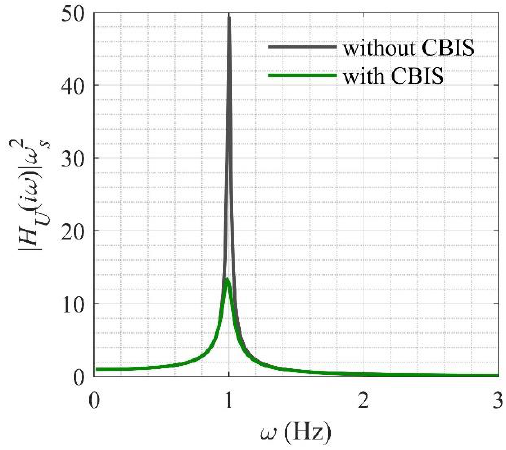
Figure 9. Displacement amplification factors.